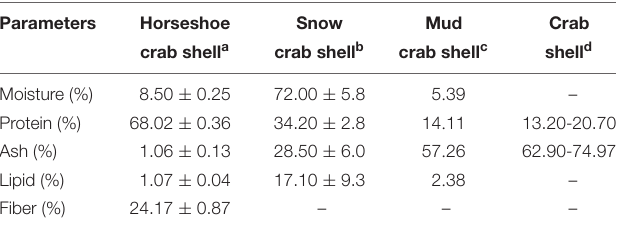
TABLE 2 | Chemical composition of mangrove horseshoe crab ( Carcinoscorpius rotundicauda ) and some crustacean shells. Parameters